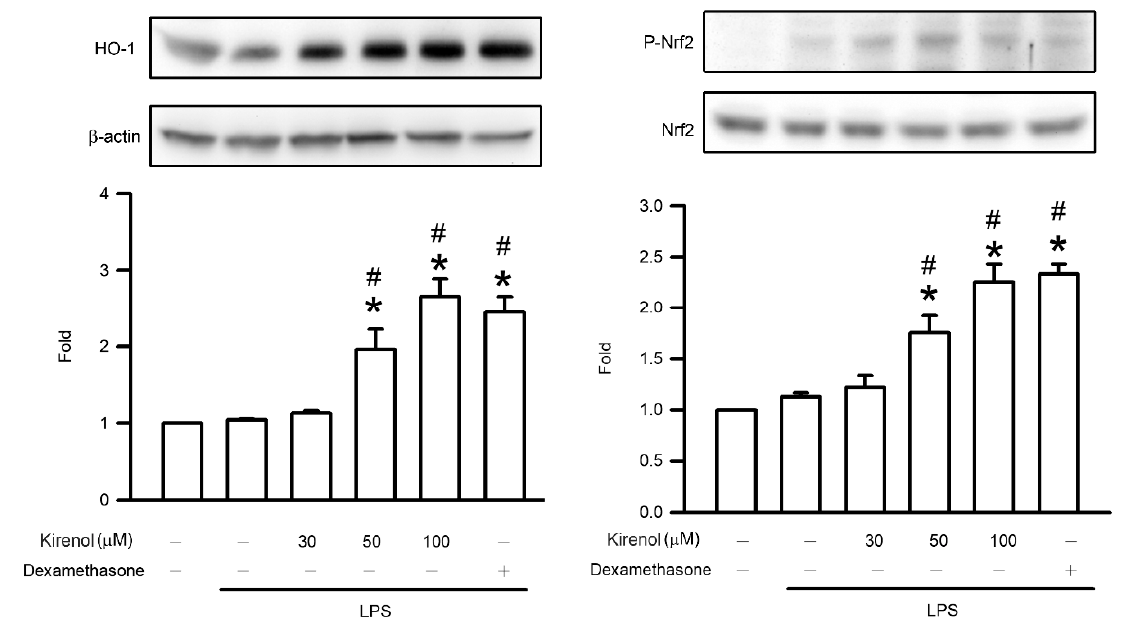
Figure 7. Kirenol enhanced the phosphorylation of Nrf2 and expression of HO-1 induced by LPS. The levels of Nrf2 phosphorylation and HO-1 expression in the lung tissues were analyzed by Western blotting analysis. Values are shown the mean ± S.D. of 3–4 mice per group. # represents the significant difference compared with the Group I ( p < 0.05); * represents the significant difference compared with the Group II ( p < 0.05).